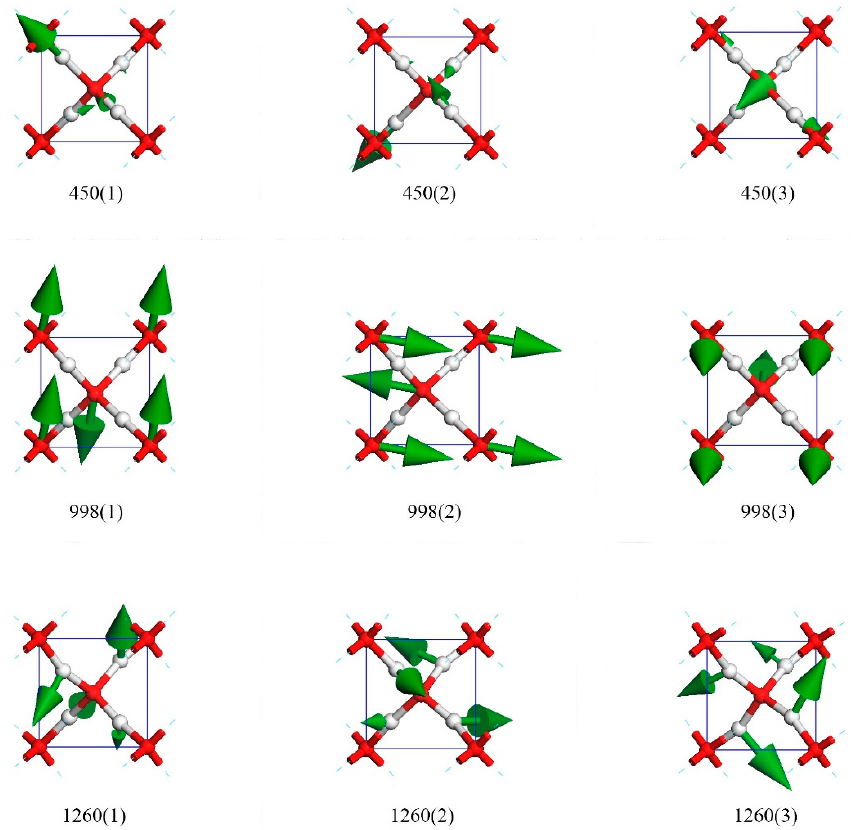
Figure 3. Nine normal vibrational modes at 450 cm − 1 , 998 cm − 1 , and 1260 cm − 1 . Each frequency has three degenerate states.